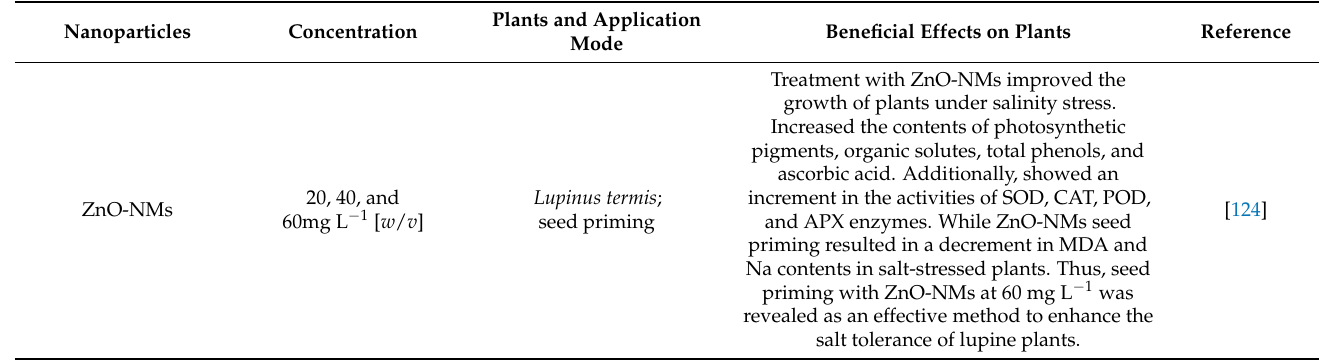
Table 1. Summary on the roles of nanotechnology for growth and development-associated benefits to the plants under soil